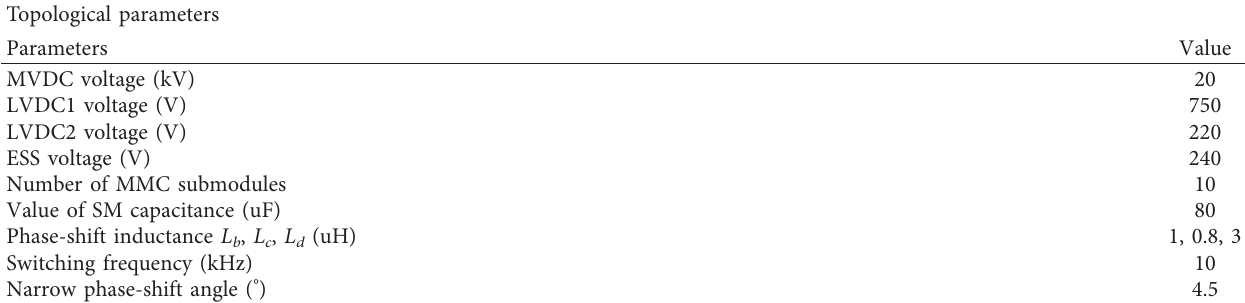
Figure 11: Control strategy of QP-M 2 DC system. Table 2: Simulation parameters.